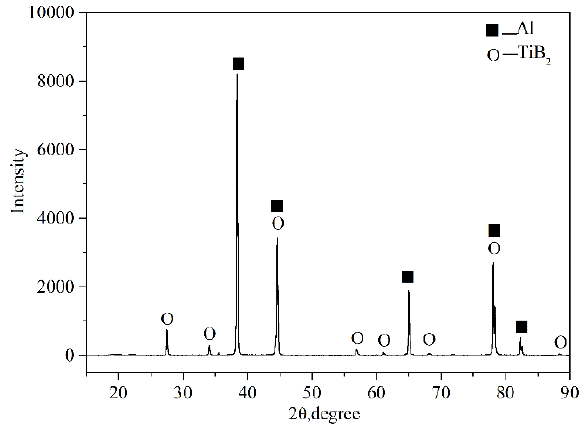
Figure 8: XRD pattern of the composite prepared at 600A.